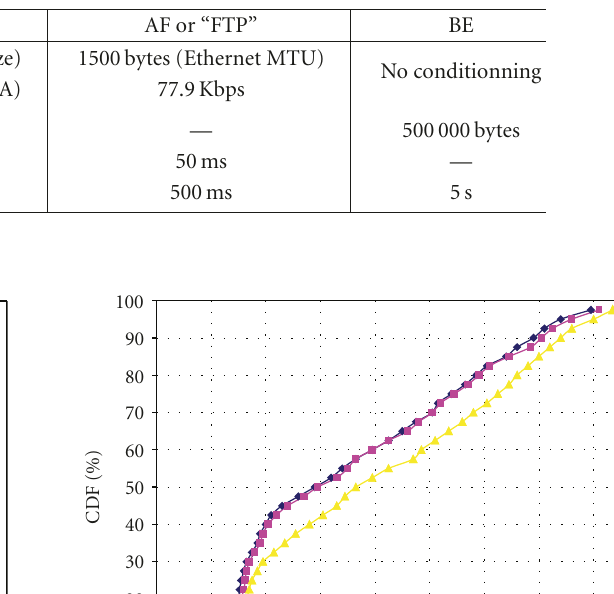
Table 2: IP TCBs and Scheduler configuration.